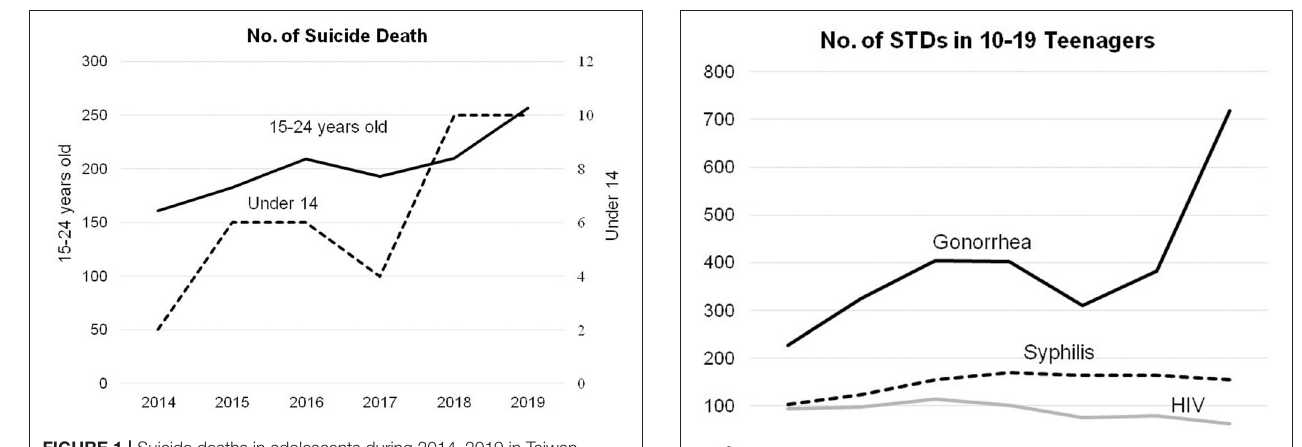
FIGURE 1 | Suicide deaths in adolescents during 2014–2019 in Taiwan.